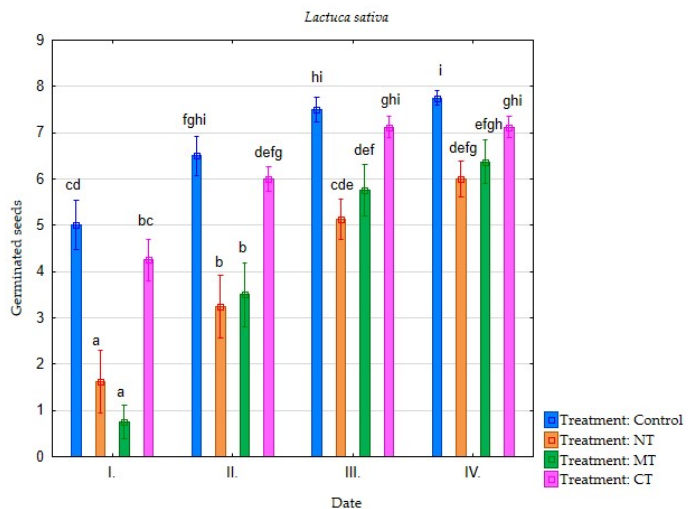
Figure 6. Development of the germination of Lactuca sativa caryopses watered with soil leachates from different soil tillage. The results represent the mean of 8 biological replicates ± SE. Identical letters express statistical non-significance between the variants, different letters express statistical significance at a significance level p = 0.05 (Fisher LSD test). The plot shows the mean, the whiskers representing the standard error, values with different letter (a, b, c, d, e, f, g, h, i) differ significantly. Variants of tillage technologies: CT—Conventional tillage with ploughing; MT—Minimum tillagethe; NT—Direct sowing.